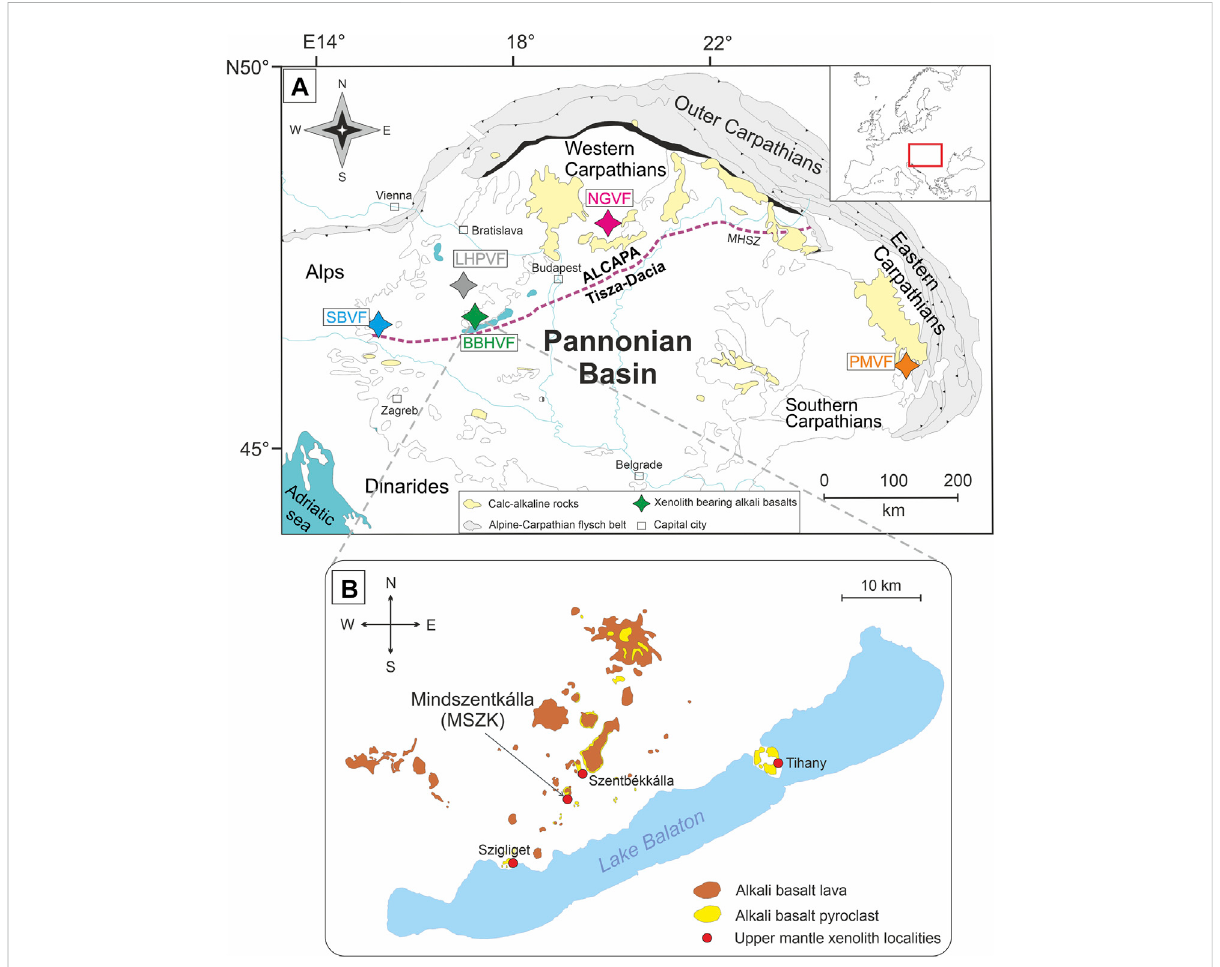
FIGURE 1 (A) Simpli fi edgeologicalmapoftheCarpathian-Pannonianregion(CPR)withtheboundaryoftheALCAPAandTisza-Daciamicroplates,andthe Mid-Hungarian shear zone (MHSZ) between them (Csontos and Nagymarosy, 1998 and references therein). Xenolith-bearing Neogene alkali basalt volcanic fi elds shown are the following: SBVF, Styrian Basin Volcanic Field; LHPVF, Little Hungarian Plain Volcanic Field; BBHVF, Bakony-Balaton Highland Volcanic Field; NGVF, Nógrád-Gömör Volcanic Field; PMVF, Persani Mountains Volcanic Field. (B) Mindszentkálla xenolith locality togetherwithotherxenolith-bearingsites(Szigliget,Szentbákkálla,Tihany)intheBakony-BalatonHighlandVolcanicField(modi fi edafterHidasetal., 2010 and references